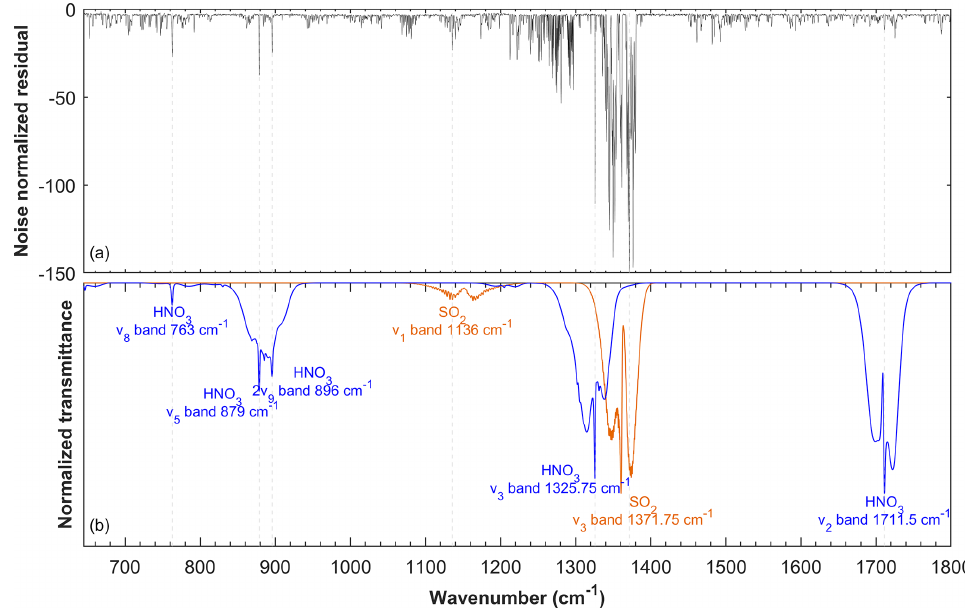
Figure 4. (a) Example of GMI pseudo-residual calculated from IASI/Metop-B L1C data during a volcanic eruption in Ubinas, Peru, on 20 July 2019 in the morning (daytime or AM orbit). (b) The HITRAN spectroscopic parameters associated with the absorption of HNO 3 and SO 2 (Gordon et al., 2017, 2022) are shown in blue and in orange, respectively.